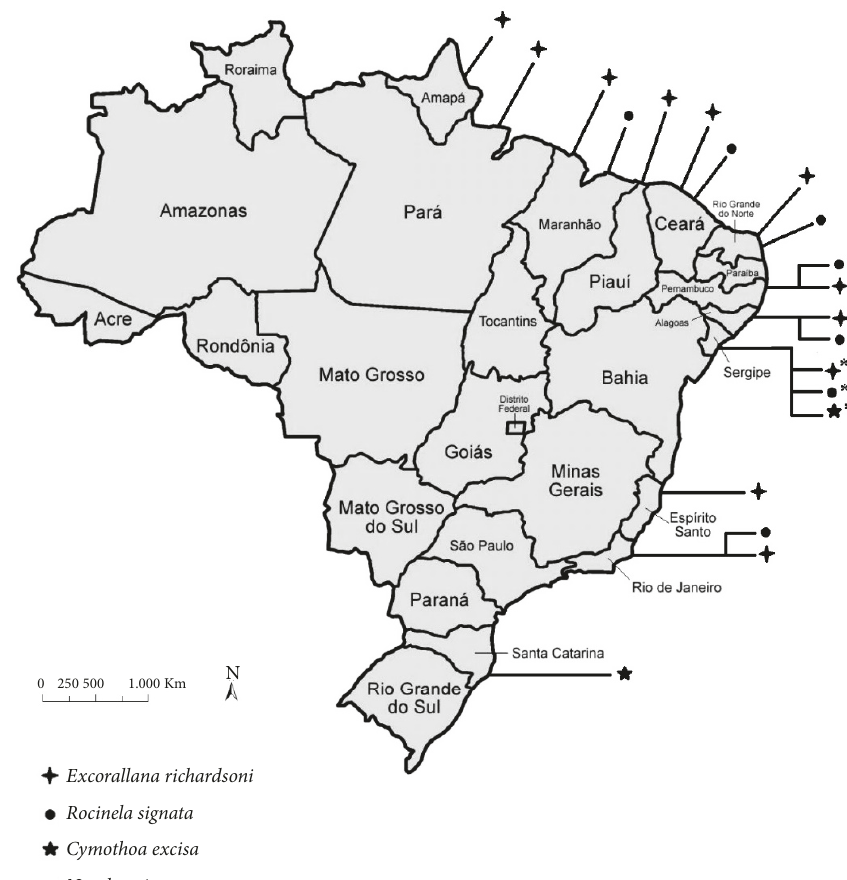
Figure 6: Map showing the distribution of the three species of isopods - Rocinela siganta , Cymothoa excisa, and Excorallana richardsoni in Brazil. The new location is highlighted. Source: Adapted and edited from